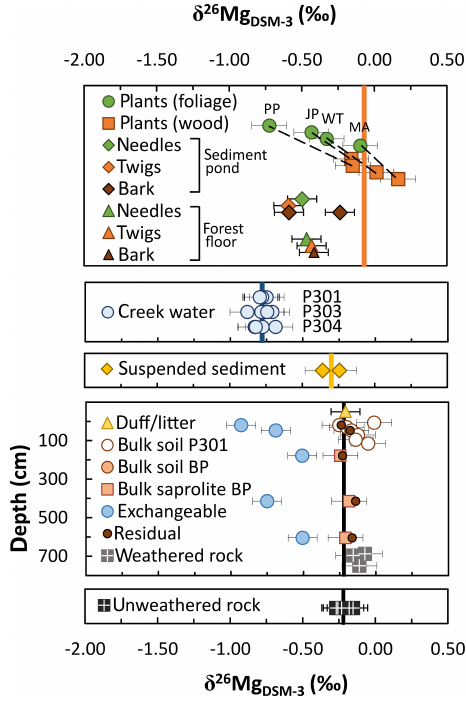
Figure 3. Magnesium isotopic composition of the compartments at Providence Creek, Southern Sierra Nevada, USA. Vertical lines rep- resent mean δ 26 Mg values of bulk unweathered rock (black), bulk suspended sediment (yellow), bulk tree (orange; for mass balance see Appendix A) and creek water (blue). The diagonal dashed lines connect woody with non-woody plant material of the same sam- ple. Exchangeable and residual refer to sequentially extracted soil phases. P301, P303 and P304 refer to headwater catchments at Prov- idence Creek. BP refers to the soil–saprolite profile (balsam profile). PP refers to ponderosa pine ( Pinus ponderosa ), JP refers to Jeffrey pine ( Pinus jeffreyi ), WT refers to whitethorn ( Ceanothus cordula- tus ) and MA refers to manzanita ( Arctostaphylos manzanita ). Error bars amount to 0.10‰